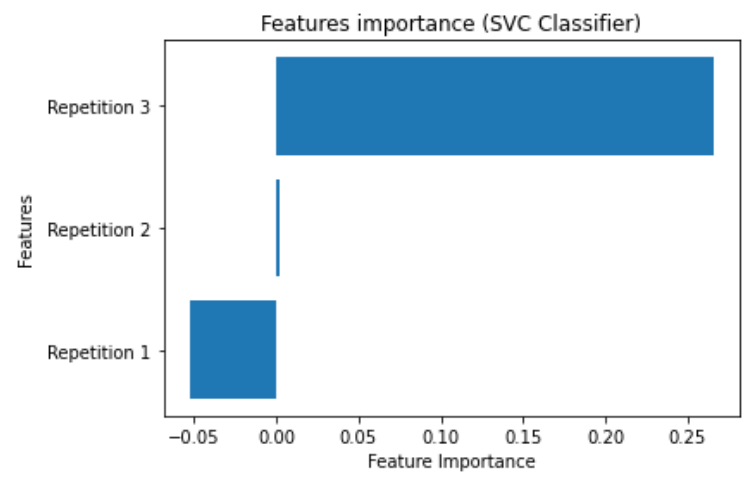
Figure A2. SVM features predictive